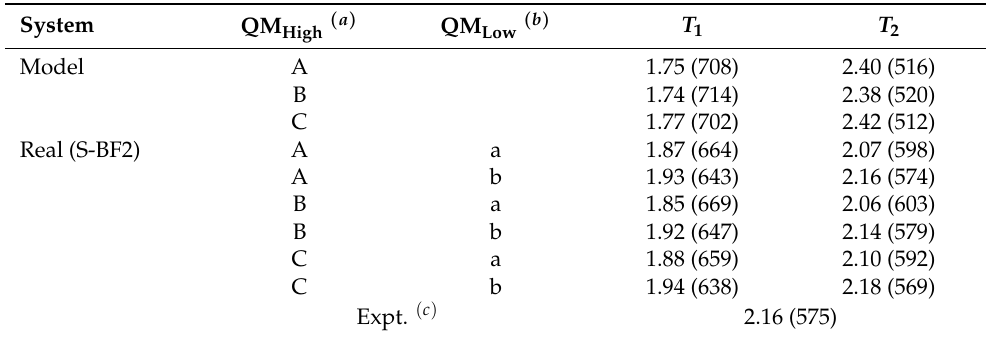
Table 1. Emission energies (in eV) and emission wavelengths (in parentheses; nm) of T 1 and T 2 of S-BF2 by ONIOM (QM High :QM Low